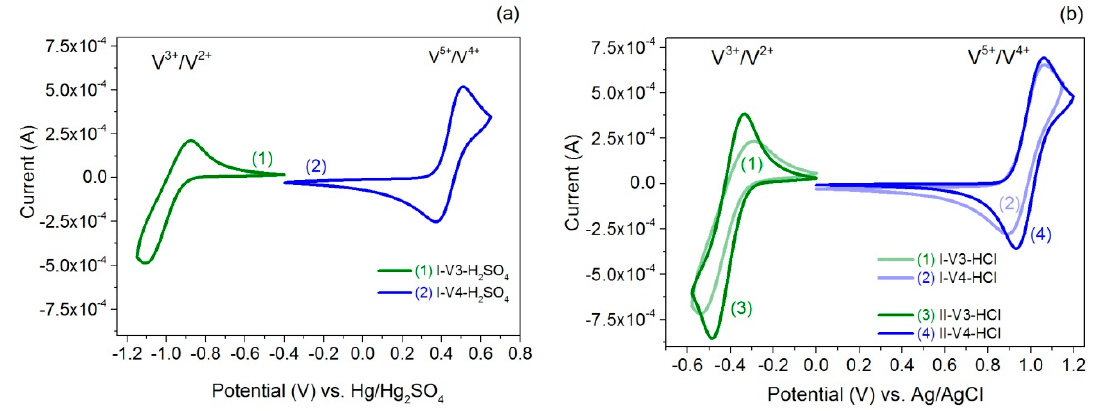
Figure 2. Cyclic voltammograms recorded at 20 mV ∙ s − 1 at a pre-treated glassy carbon electrode in the electrolyte samples of V(III) and V(IV) in ( a ) H 2 SO 4 and ( b ) HCl media.